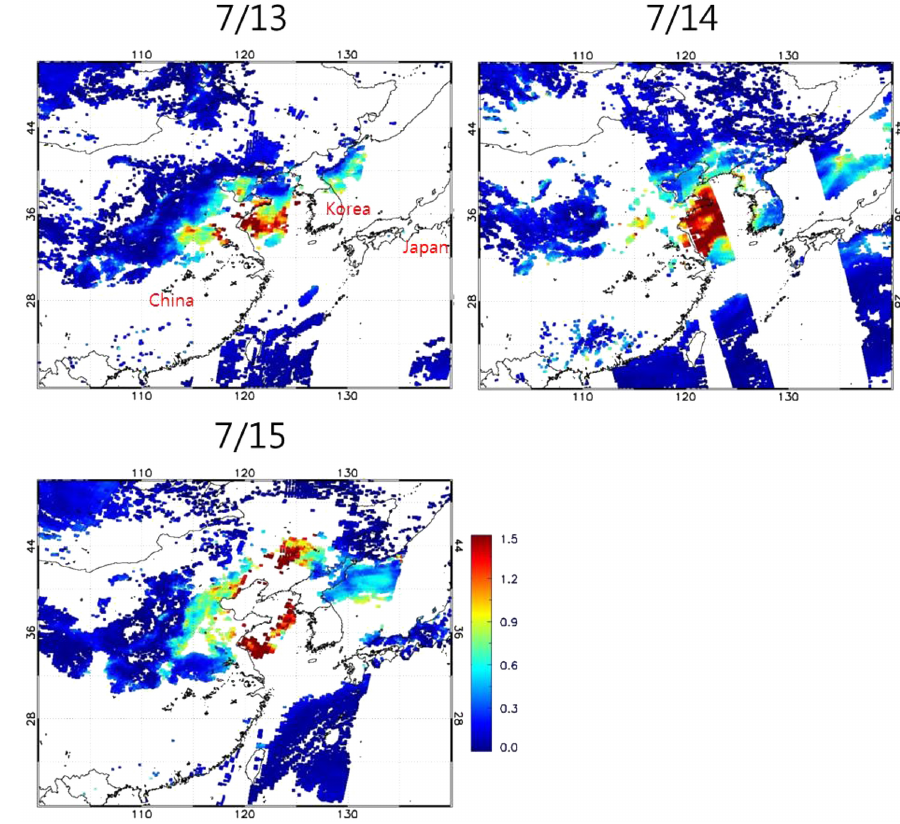
Figure 8. MODIS AOD over East Asia between 13 and 15 July 2014.